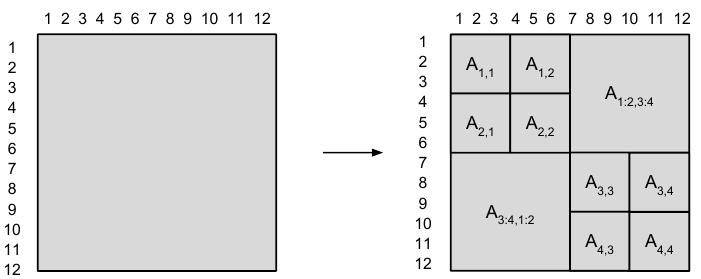
Fig. 2 H -matrix obtained by applying the partitioning defined by the block cluster tree in Figure 1 over an 12 × 12